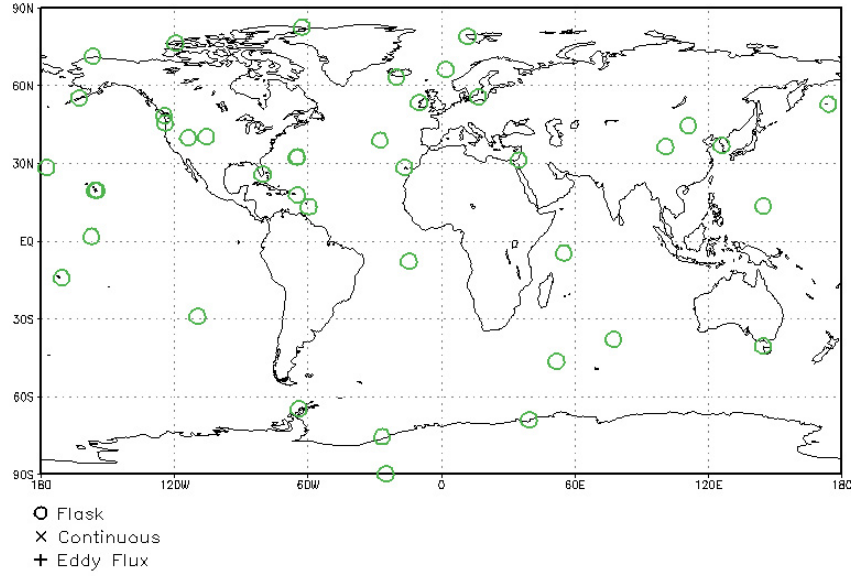
Fig. 3. Observational network flask providing atmospheric flask